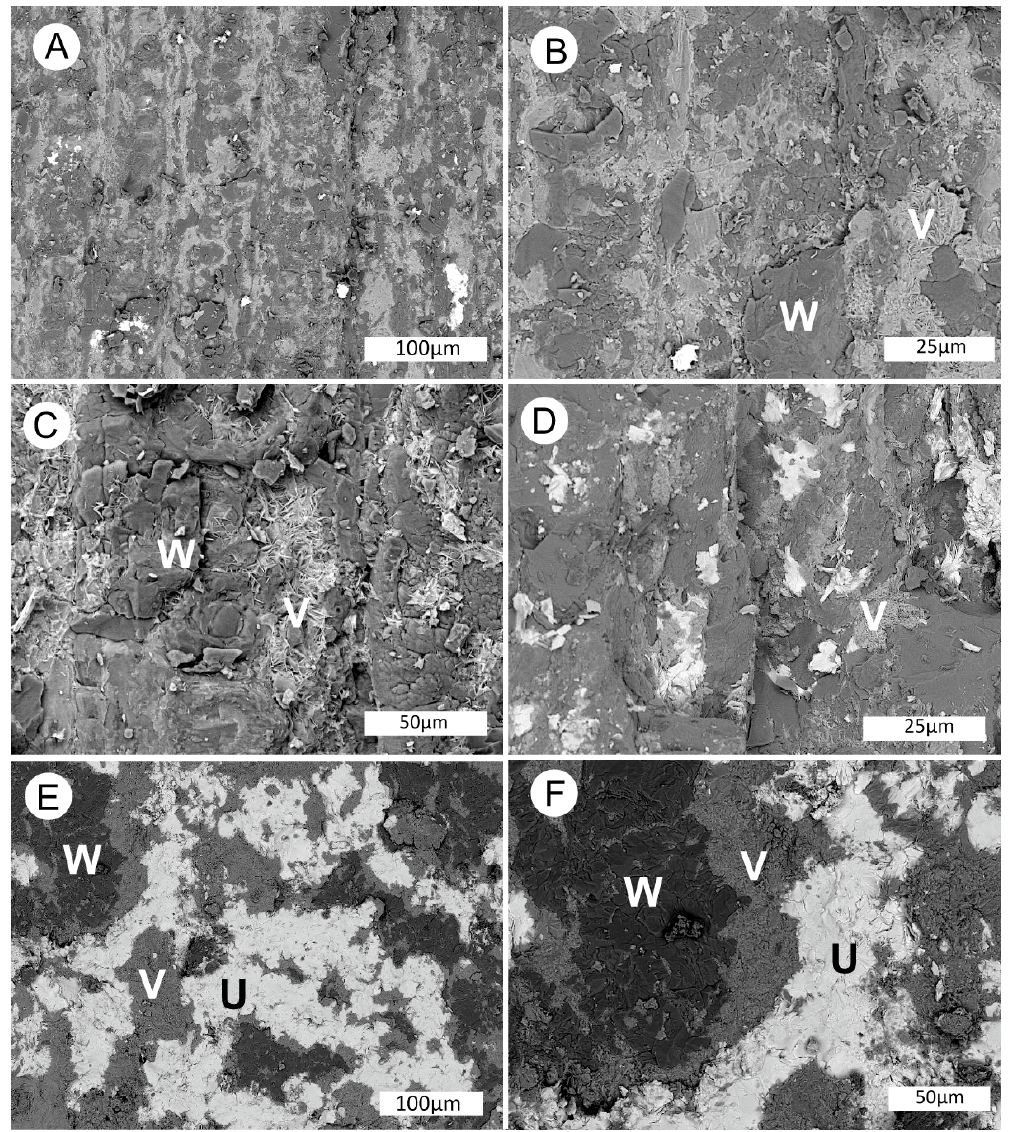
Figure 21. SEM images of fossil wood from Monment #2 Mine. ( A–C ) Longitudinal view of tracheid cells containing fossil wood ( W ) and a vanadium mineral ( V ). ( D–E ) Fossil wood containing a vanadium mineral and tyuyamunite ( U ), a uranium mineral.